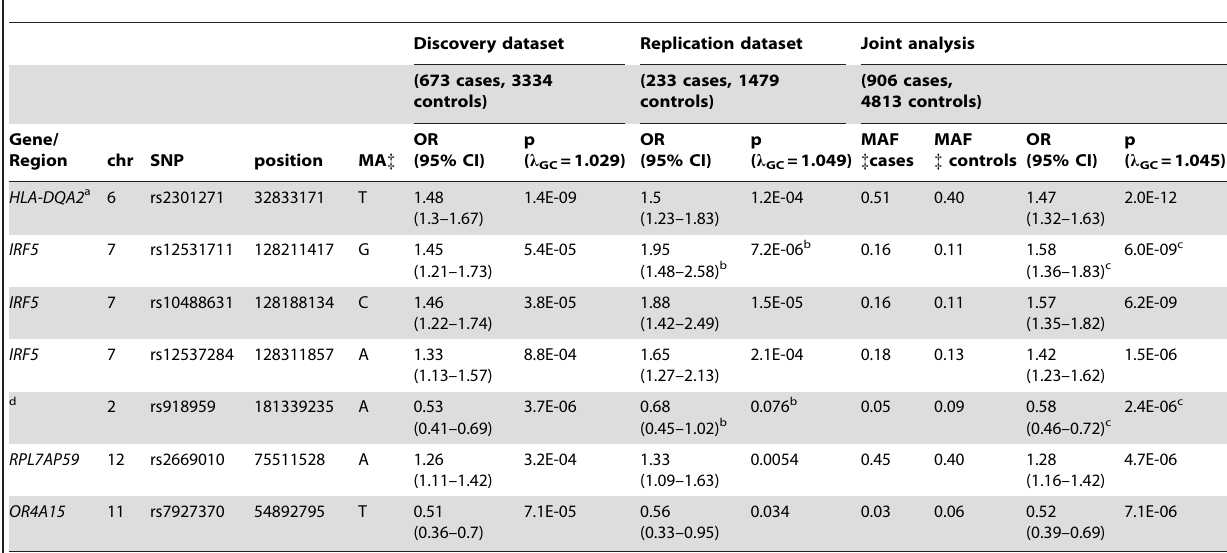
Table 3. SNPs with significant (p , 5E-07) or suggestive (p between 5E-07 and 1E-05) evidence for association with anti–dsDNA – SLE identified in the joint analysis.